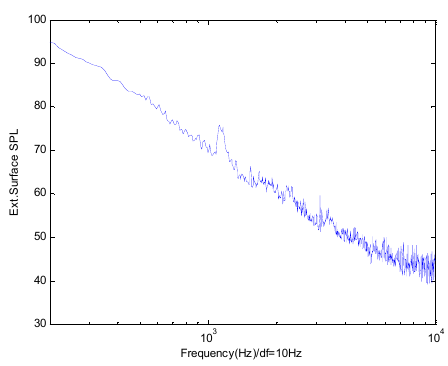
Figure 12. The RMS of the space average pressure on the side mirror surface.